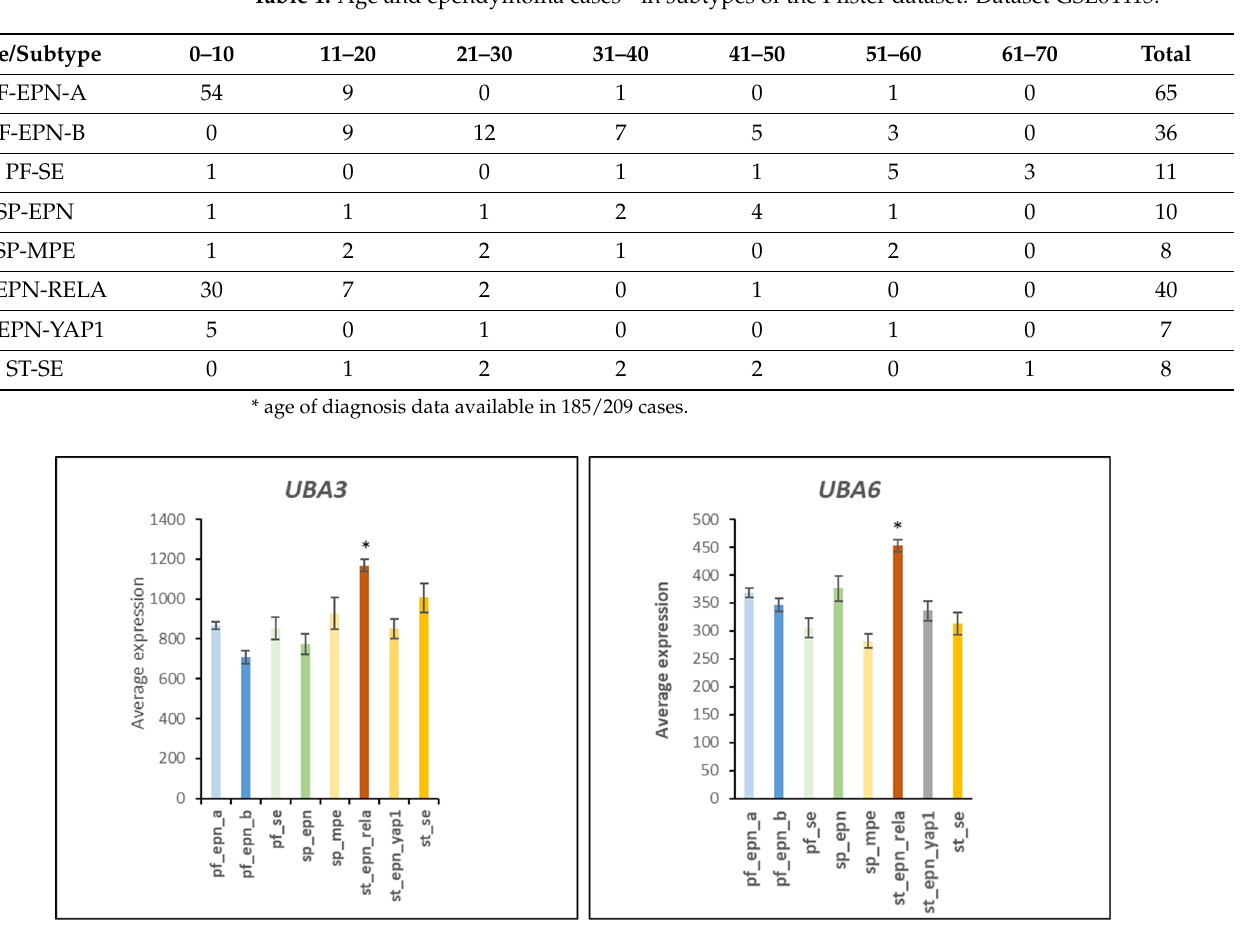
Figure 1. Differential expression of genes encoding E1 ubiquitin activating enzymes by Anova, UBA3 (F = 20.60, p = 9.29 × 10 − 21 ) and UBA6 (F = 14.19, p = 6.22 × 10 − 15 ) in EPN subtypes. * Expression of UBA3 and UBA6 were significantly elevated in ST_EPN_RELA compared to all other EPN subtypes by at least p < 0.01 (with the exception of SP_MPE for UBA3 ) as determined by t -test. Dataset GSE64415.